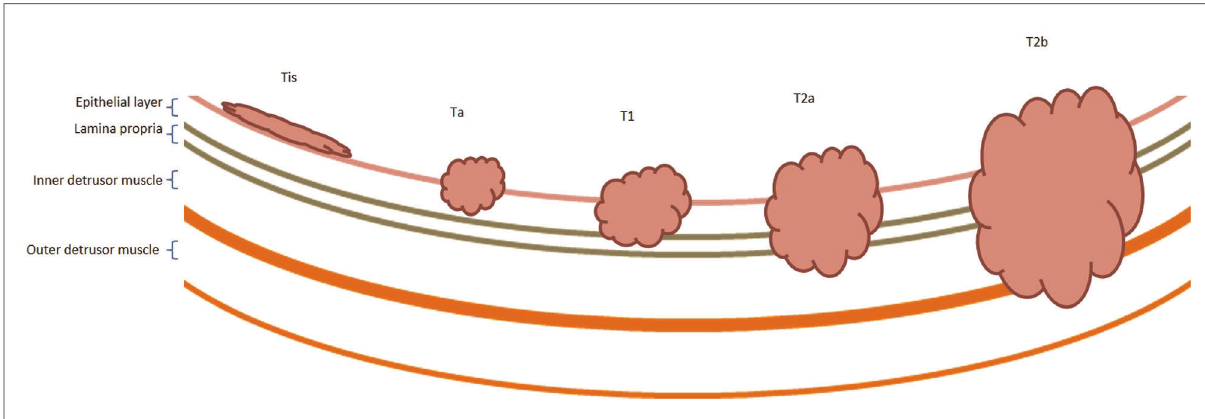
FIGURE 1 Non-muscle and muscle-invasive bladder cancer. Bladder cancer is described as non-muscle or muscle invasive. Non-muscle invasive bladder cancer includes Tis, Ta and T1 disease, as described by the TNM staging system (131). Tis lesions are typically located on the luminal surface. Ta tumours extend into the urothelium, and T1 tumours extend into the lamina propria. Muscle-invasive bladder cancers include T2, T3 and T4 disease. T2 tumours extend into the inner half (T2a) and outer half (T2b) of the detrusor muscle, respectively. T3 tumours extend in to the perivesical fat and lymph nodes and T4 tumours invade organ systems. T3 and T4 tumours are not shown within this